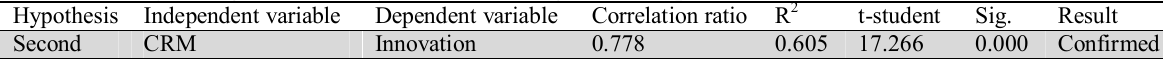
The summary of regression analysis between organization performance and innovation Hypothesis Independent